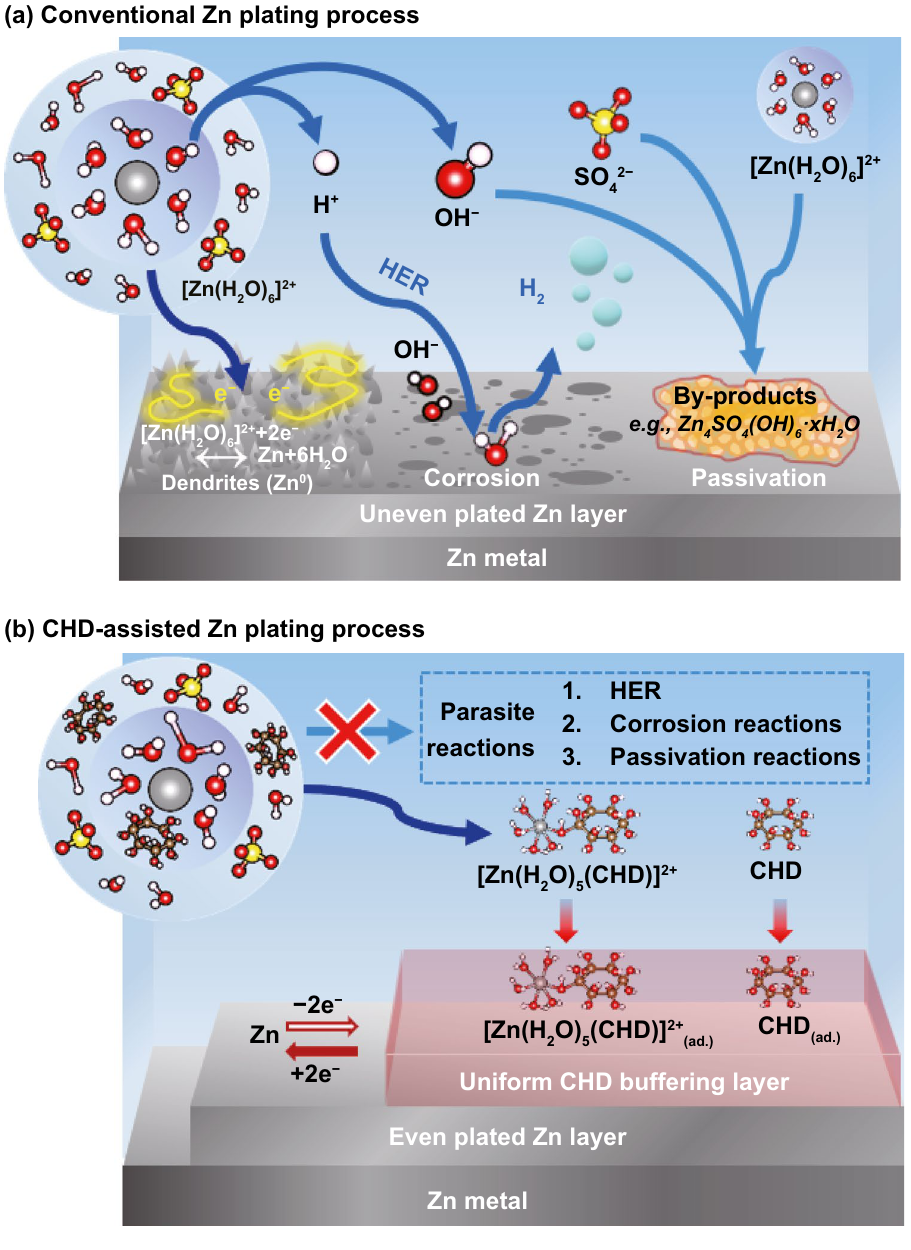
Fig. 1 The schematic diagram of zinc (Zn) plating processes in a typical aqueous Zn‑ion battery (AZIB). a The typical complex ion, [Zn(H 2 O) 6 ] 2+ , results in the parasite reactions, including HER, corrosion, dendrite formation, and the passivation on the Zn electrode within ZnSO 4 aqueous electrolyte; b a new complex ion, [Zn(H 2 O) m (CHD)] 2+ (optimal m = 5), is formed with the presence of CHD in ZnSO 4 aqueous electrolyte which facilitates the uniform plating/stripping of Zn